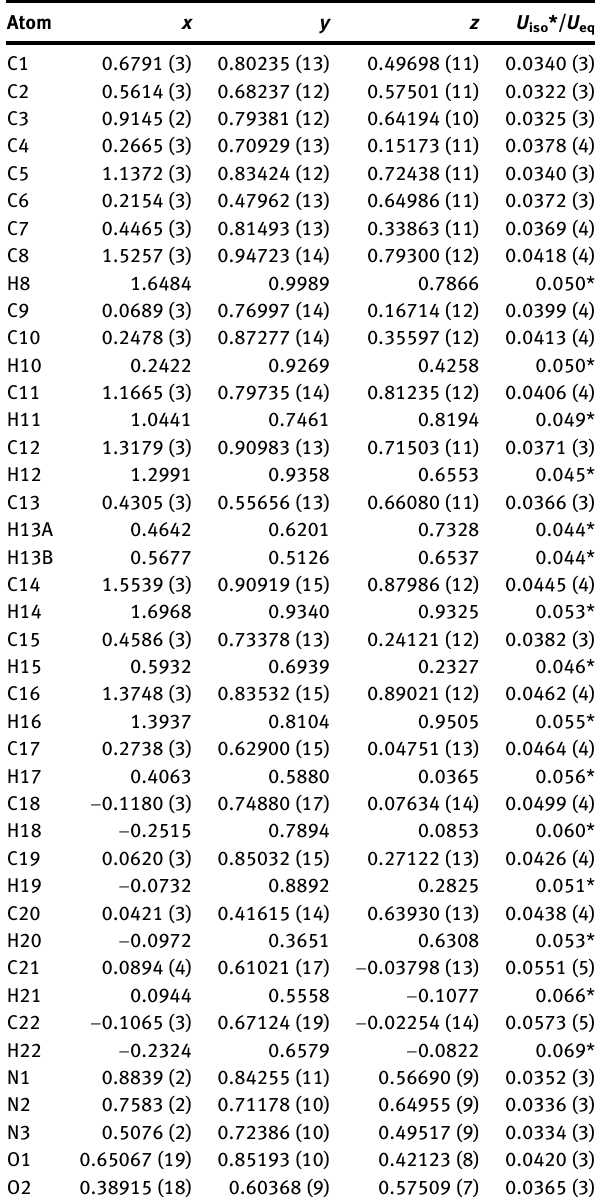
Table  : Fractional atomic coordinates and isotropic or equivalent isotropic displacement parameters (Å  ).